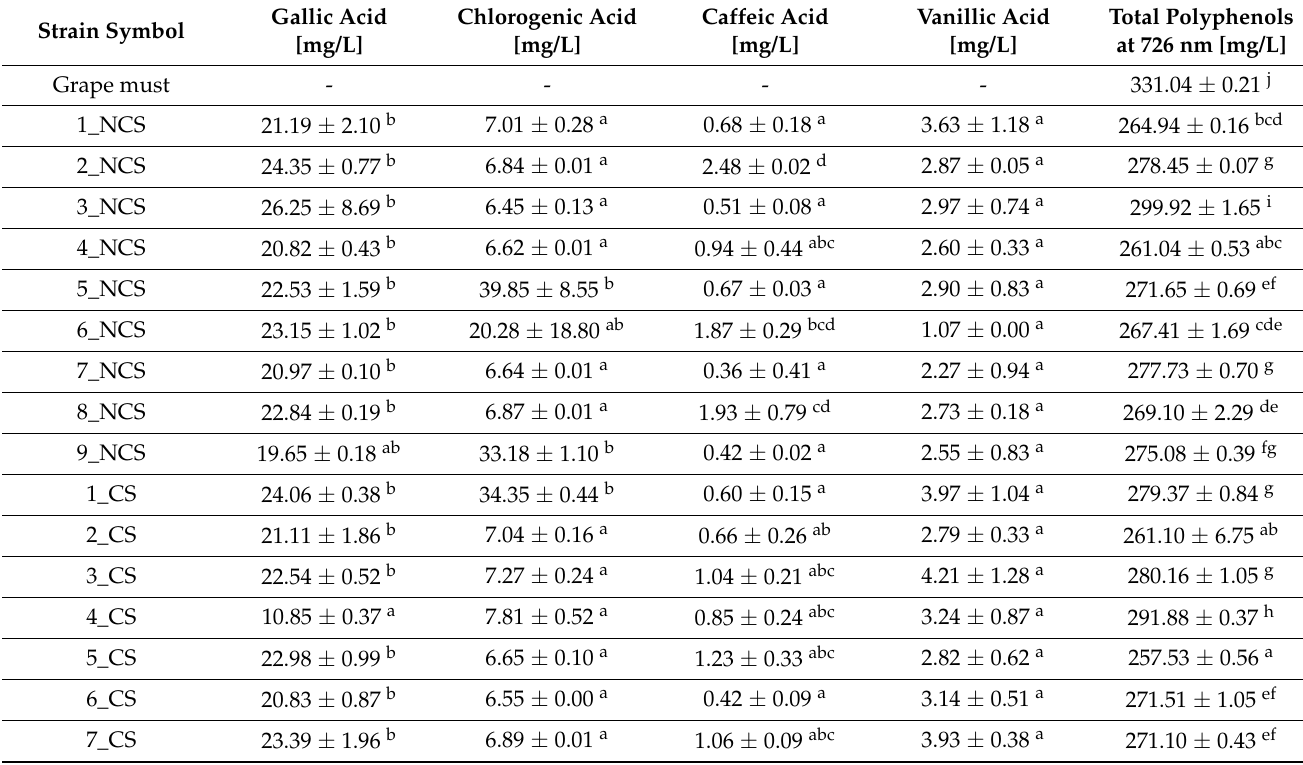
Table 3. Analysis of polyphenolic compounds in white